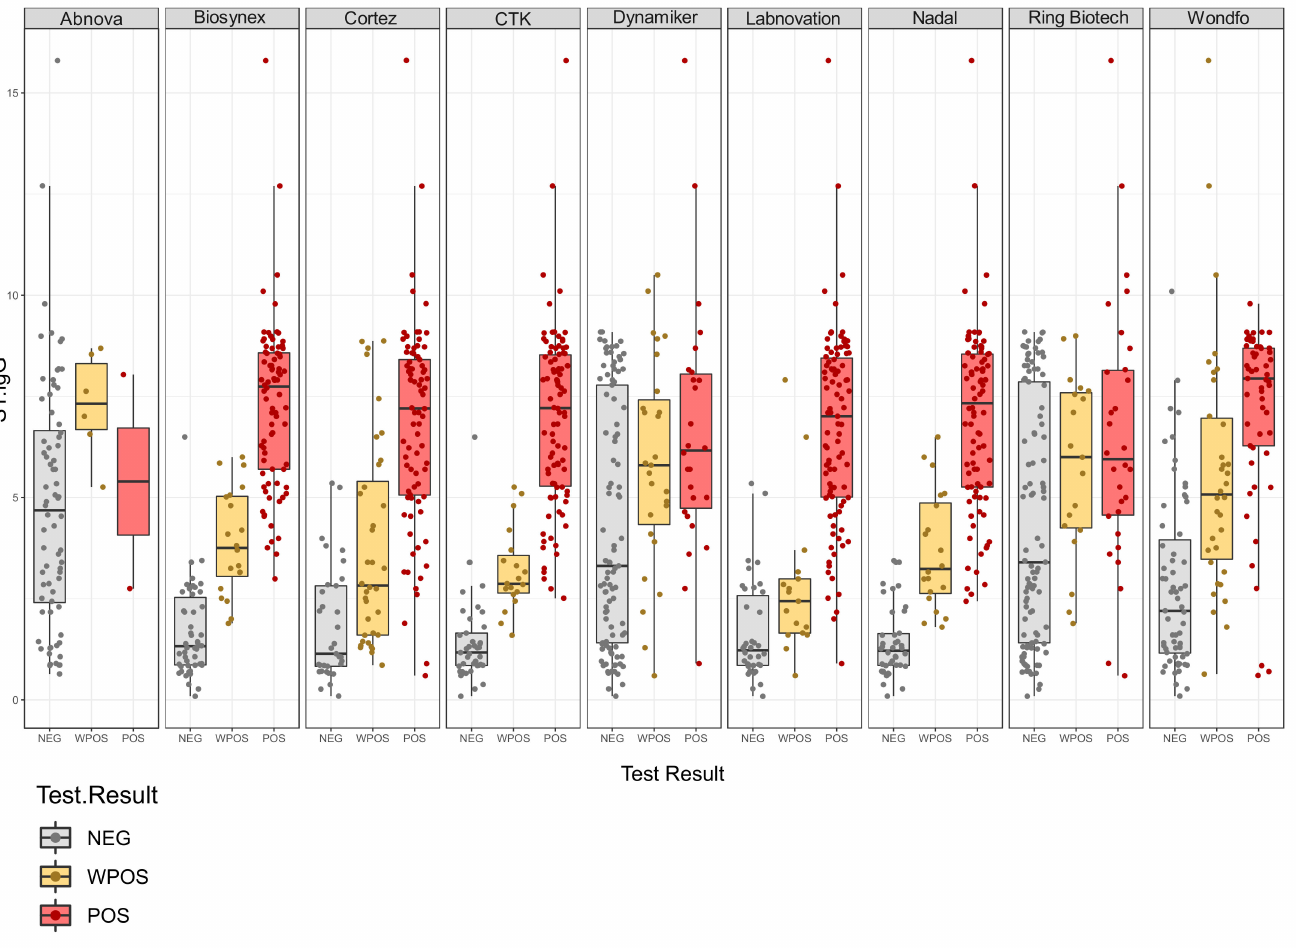
Figure 1. Plotted are the semi-quantitative LFA results ( x -axis) against the anti-spike IgG response ( y -axis). Results are categorized as negative IgG response (NEG), weakly positive IgG response (WPOS), and positive IgG response